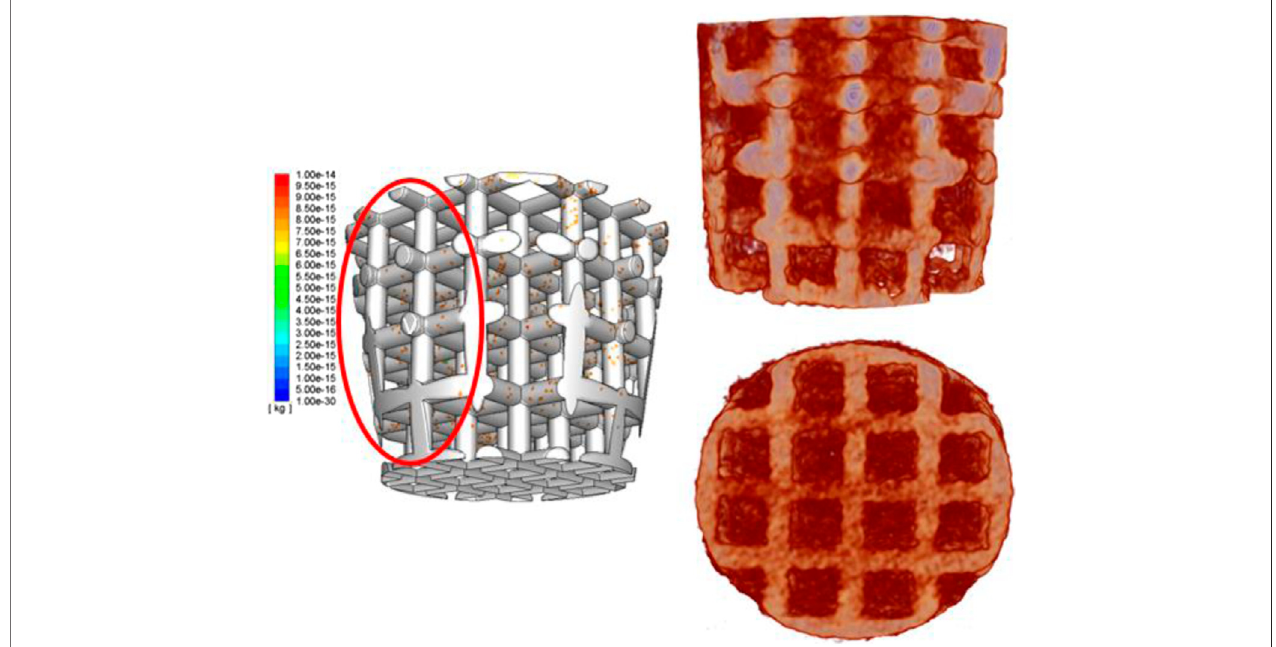
FIGURE 10 | Simulation results of cell distribution in a 3D structure (left) ; 3D-reconstructed image of the scaffold and bone tissue ingrowth (right)